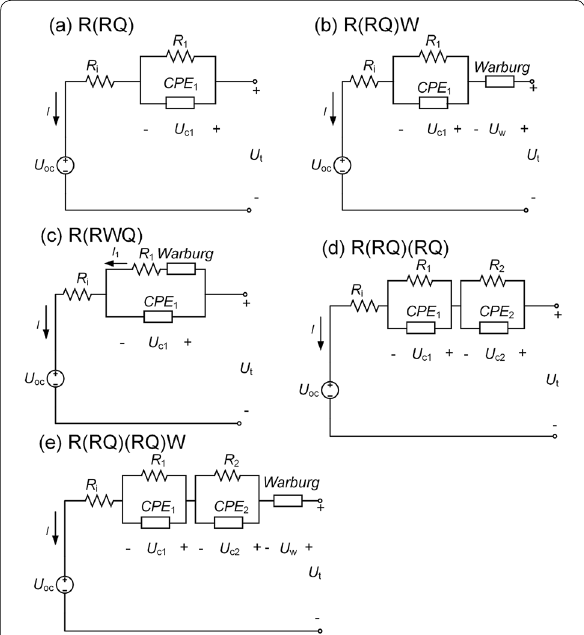
Figure 3 Five fractional order models reported in the